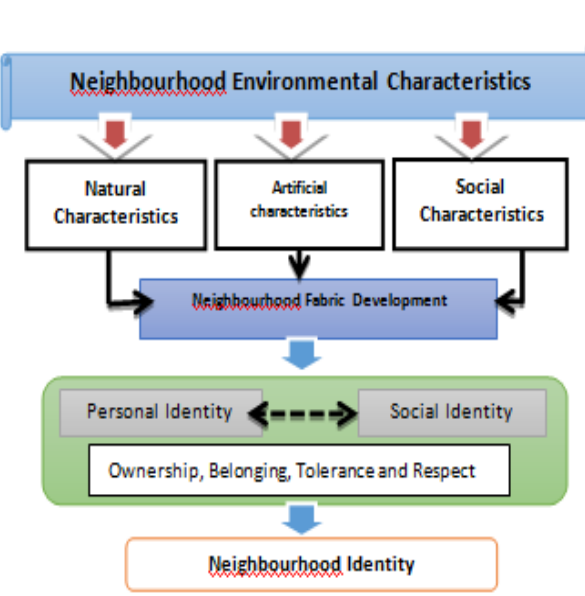
Figure 2. Neighbourhood characteristics. Adapted from Aydin and Buyuk